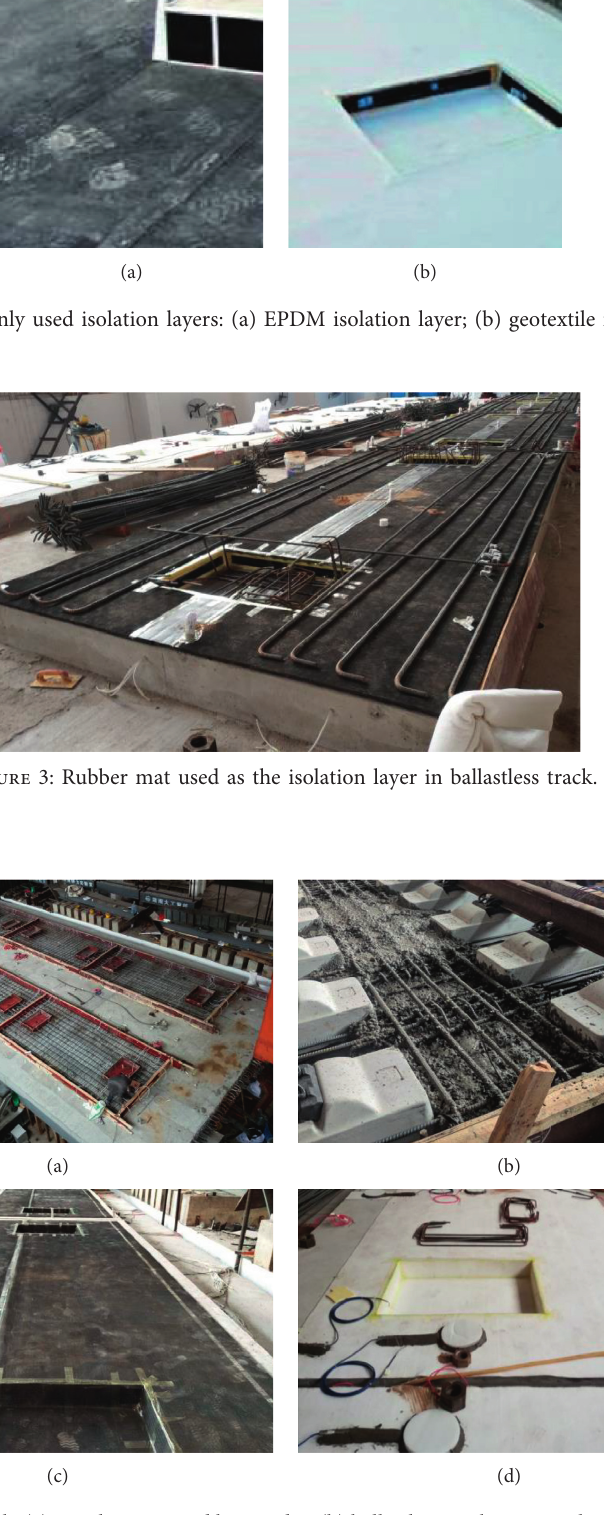
Figure 4: Test objects used in this work: (a) simply supported box girder; (b) ballastless tracks cast in place; (c) ballastless track with rubber mat isolation layer; (d) ballastless tracks with geotextile isolation